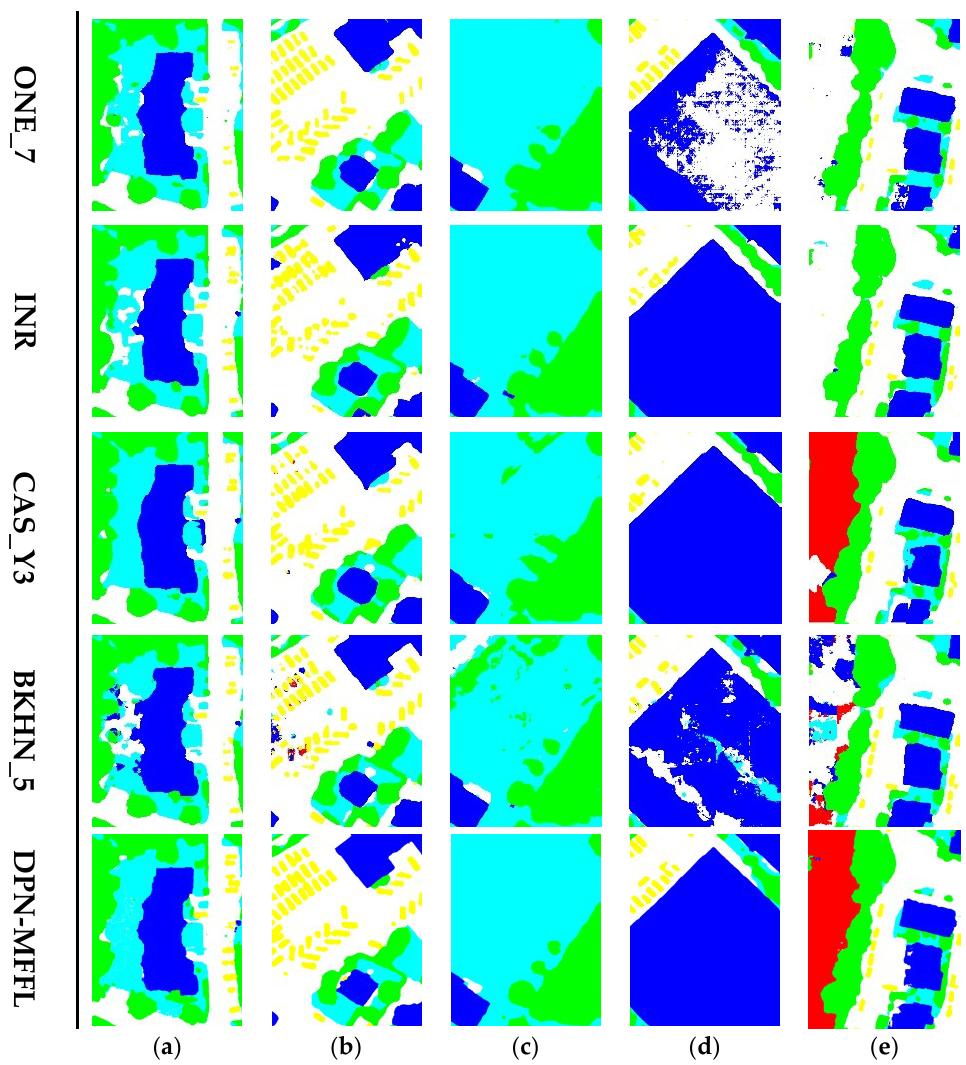
Figure 6. Qualitative comparison with other competitors’ methods on ISPRS Vaihingen challenge online test set. The label includes six categories: impervious surface (white)l building (blue); low vegetation (cyan); tree (green); car (yellow); and clutter (red). Five image patches included: ( a ) low vegetation in the shadow of building; ( b ) cars in a parking lot; ( c ) trees and low vegetation; ( d ) a large building; and ( e ) city waters.